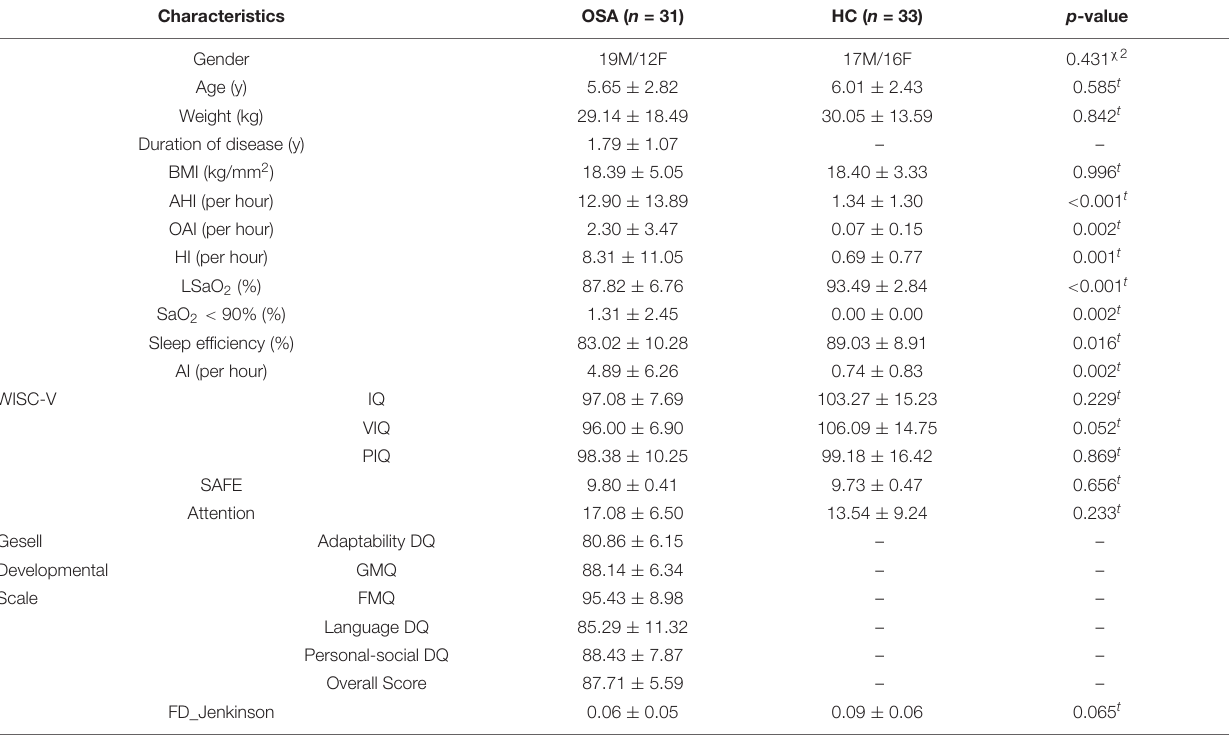
TABLE 1 | Demographic and clinical characteristics of OSA patients and healthy controls.